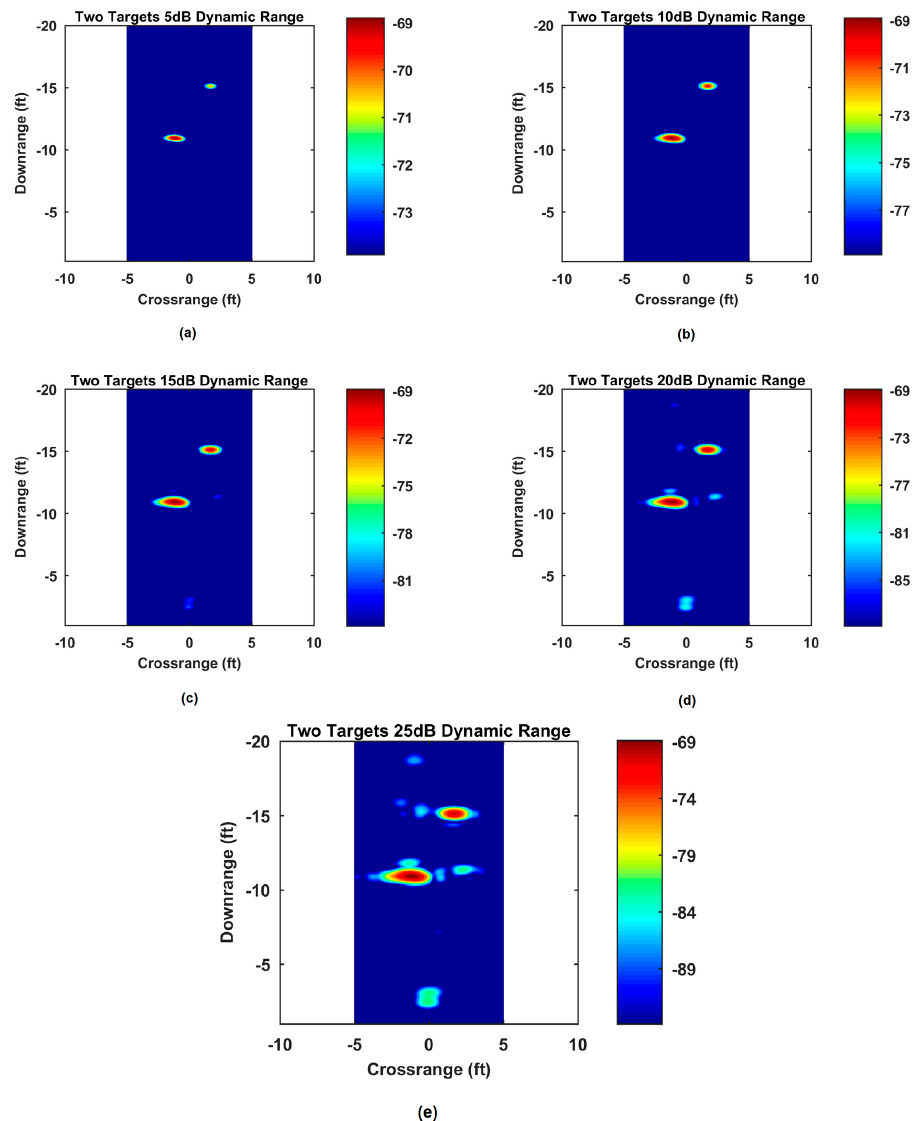
Figure 11. Images of multi-target View 2 over 5–25 dB image dynamic range: ( a ) 5 dB; ( b ) 10 dB; ( c ) 15 dB; ( d ) 20 dB; ( e ) 25 dB.